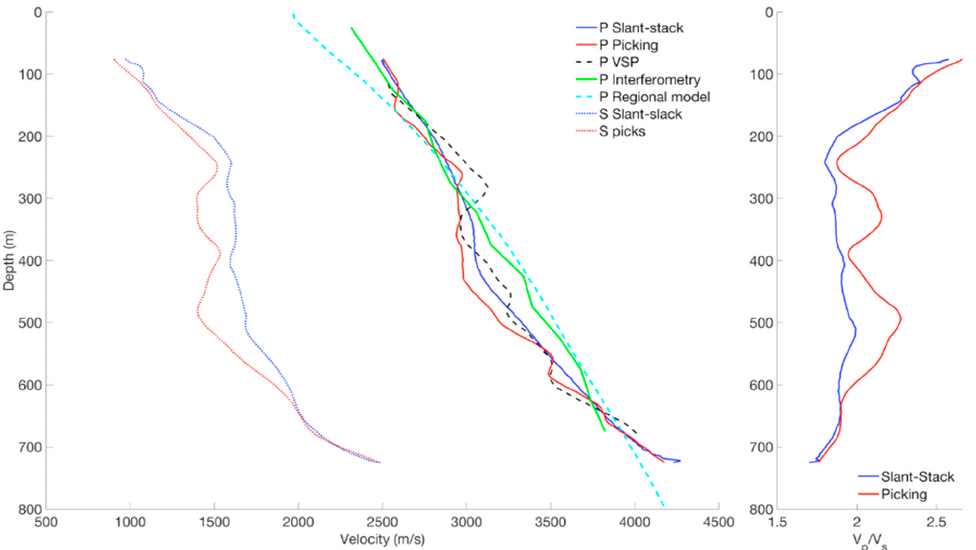
Figure 8. Seismic velocities estimated in a DAS-VSP well. The result of a zero-offset VSP survey with geophones (dashed black line) agrees very well with velocities derived using a recorded earthquake (solid blue and red lines). Earthquake analysis also yields a shear-wave velocity profile (dotted blue and red) which cannot be obtained from the VSP survey. Ambient seismic signals can be used to recover P-wave velocity (green) with low-frequency resolution. Figure from Lellouch et al. (2019), Journal of Geophysical Research: Solid Earth.